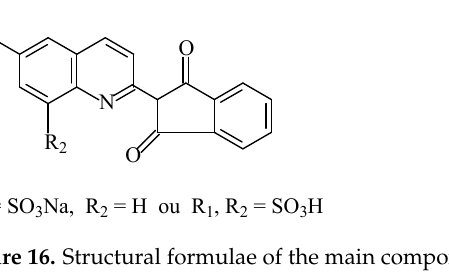
Figure 16. Structural formulae of the main components of quinoline yellow (E104).